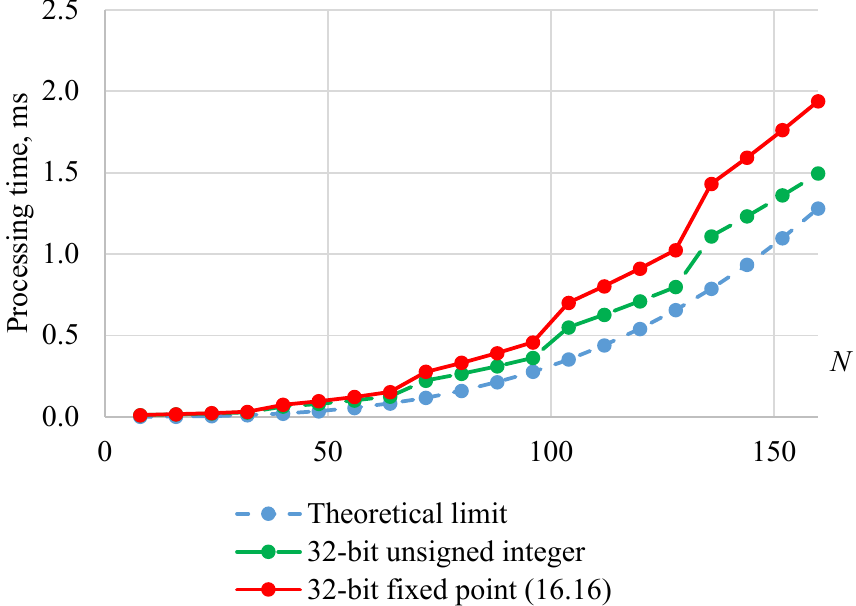
Figure 10. Processing time for matrix multiplication of 32-bit unsigned integers, 16.16 fixed point numbers, and a theoretically achievable limit depending on matrix size.